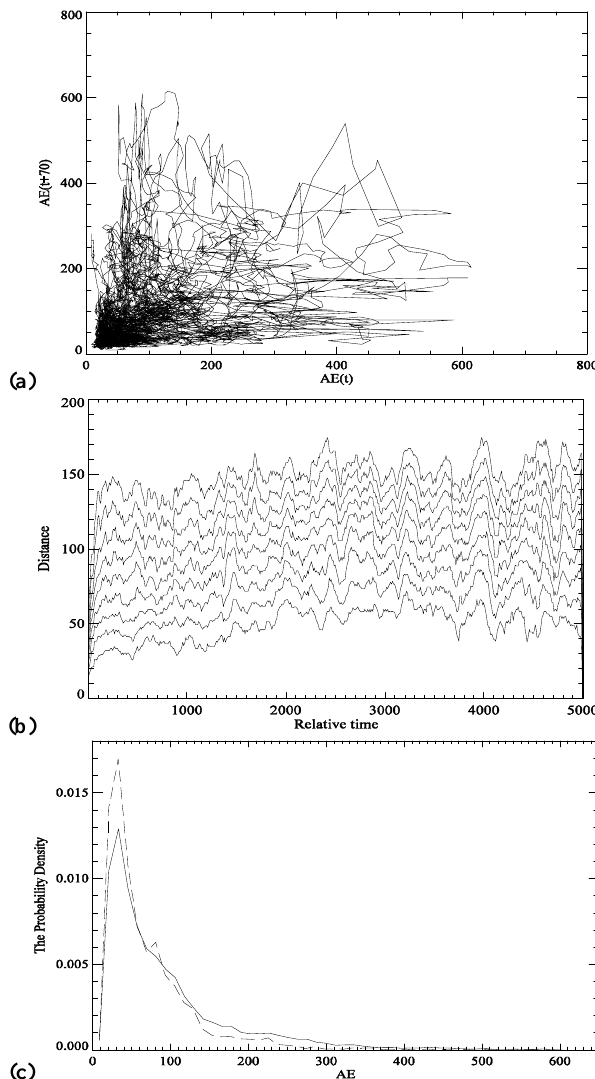
Figure 2c Fig. 2. (a) The plot of reconstructed phase space for the time series of AE index, using time delay embedding for τ =70 and m =5, (b) space time separation plot, and (c) the plot of probability density function based on the entire time series and on the first half of the series (continuous and dashed lines respectively), during the quiet period, 5–11 January